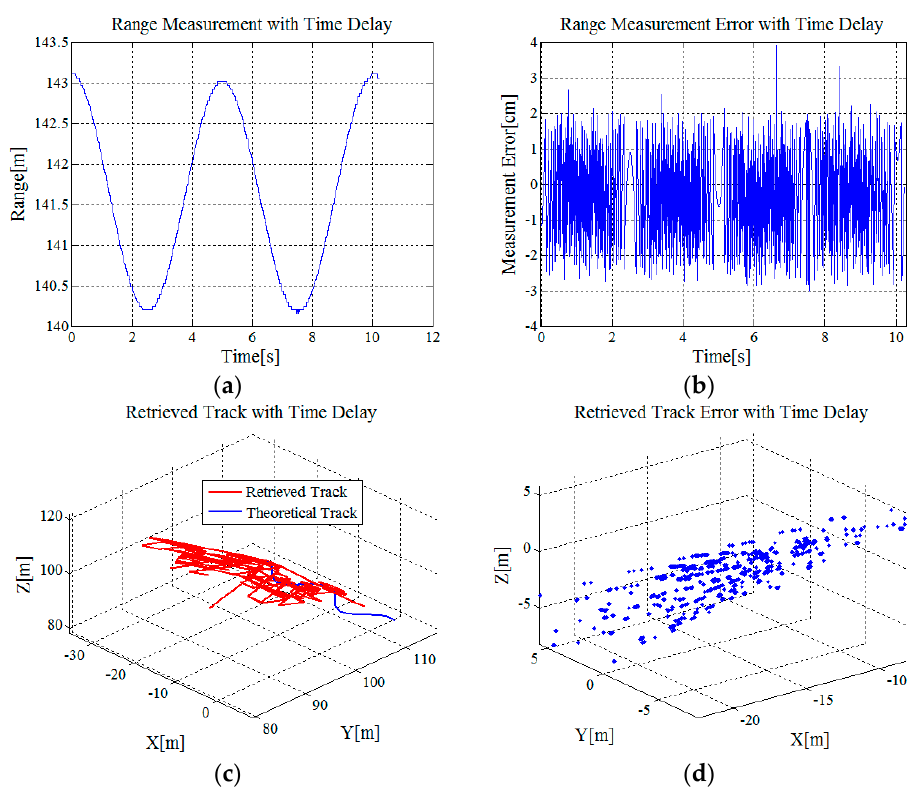
Figure 4. Measurement results: ( a ) Range measurement result with the time delay; ( b ) range measurement error; ( c ) retrieved result of the target’s 3-D track with range information derived from the time delay; and ( d ) retrieved error of the target’s 3-D track.